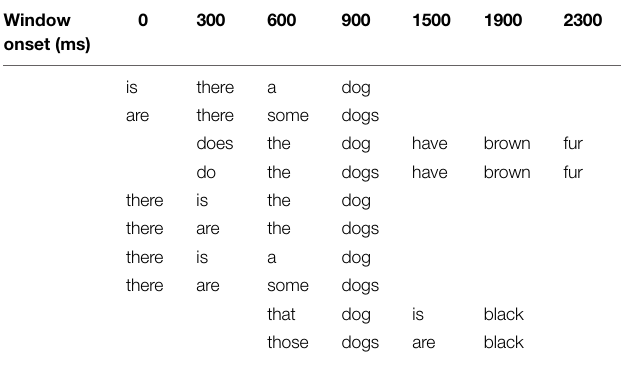
TABLE 4 | Experiment 3 alignment of different sentence